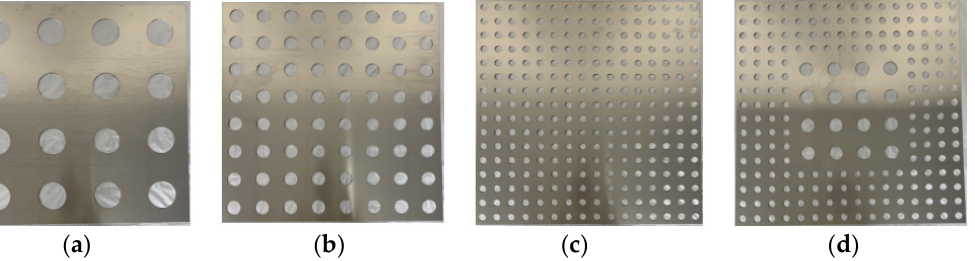
Figure 14. Physical picture of meshed aluminium plate, ( a ) 4 × 4, ( b ) 8 × 8, ( c ) 16 × 16, ( d ) non-uniform.